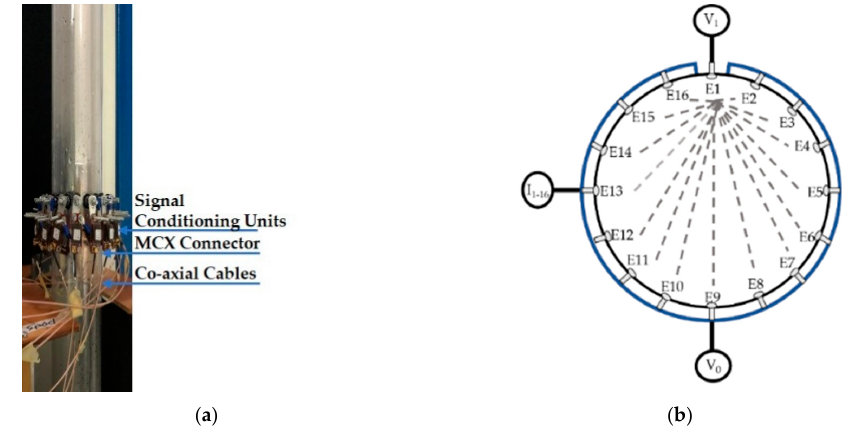
Figure 5. ( a ) Physical 16 electrode single layer ERT sensor placed above the swirl element ( b ) Schematics of VC-based ERT data acquisition system.